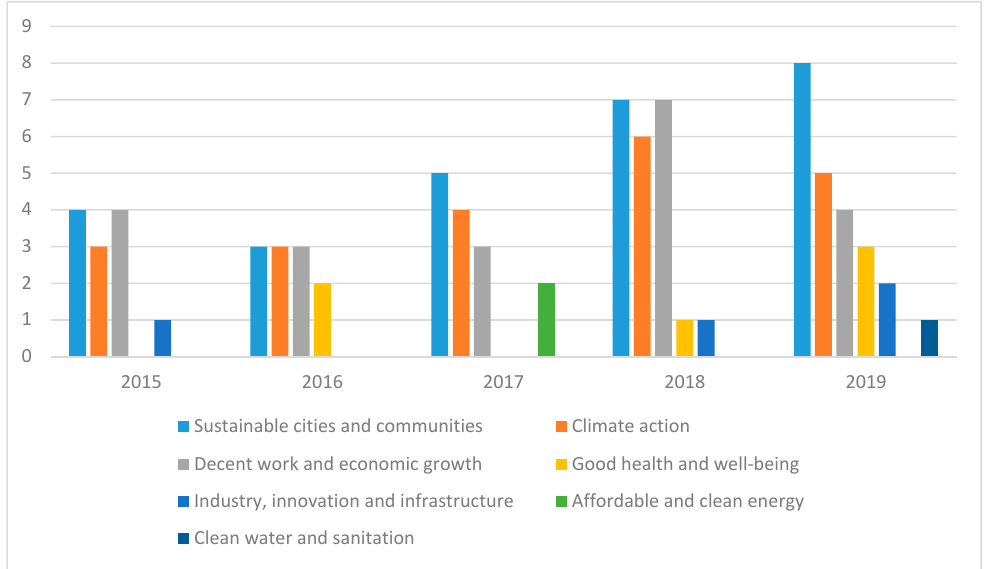
Figure 4. Relation and focus of studied papers towards UN sustainable development goals.